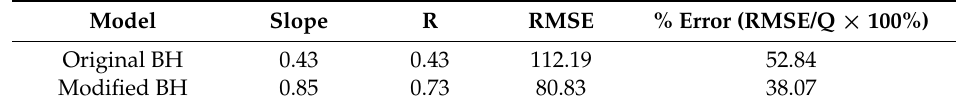
Table 2. Metrics comparing observed and modeled long‐term annual average runoff for all 64 catchments. Runoff was predicted using the original Budyko equation (top row) and improved Budyko equation with snowmelt water (bottom row).